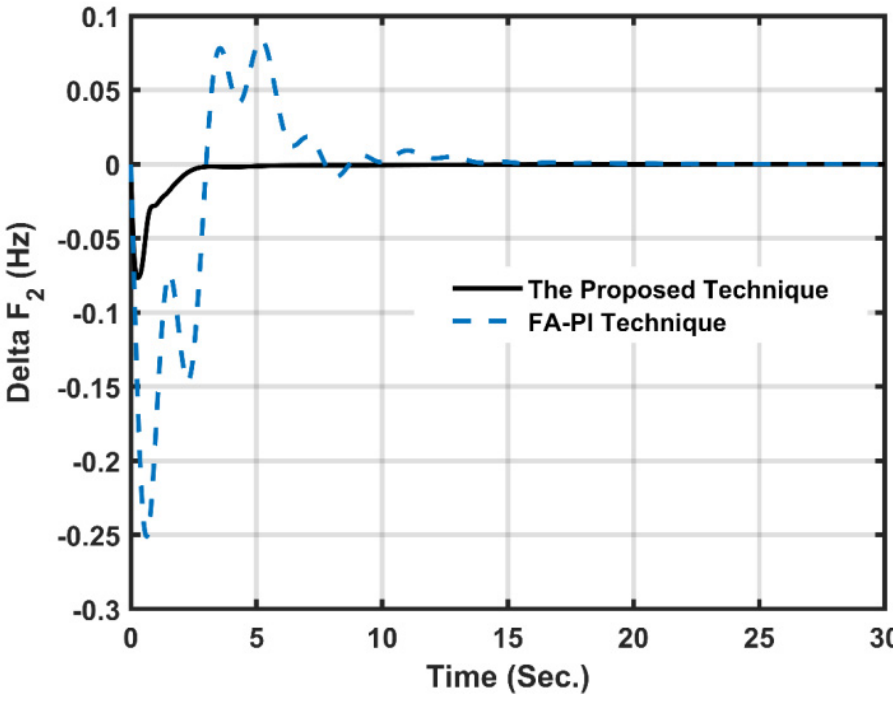
Figure 19. Frequency deviation in area 2 under disturbances in thermal and PV demands.